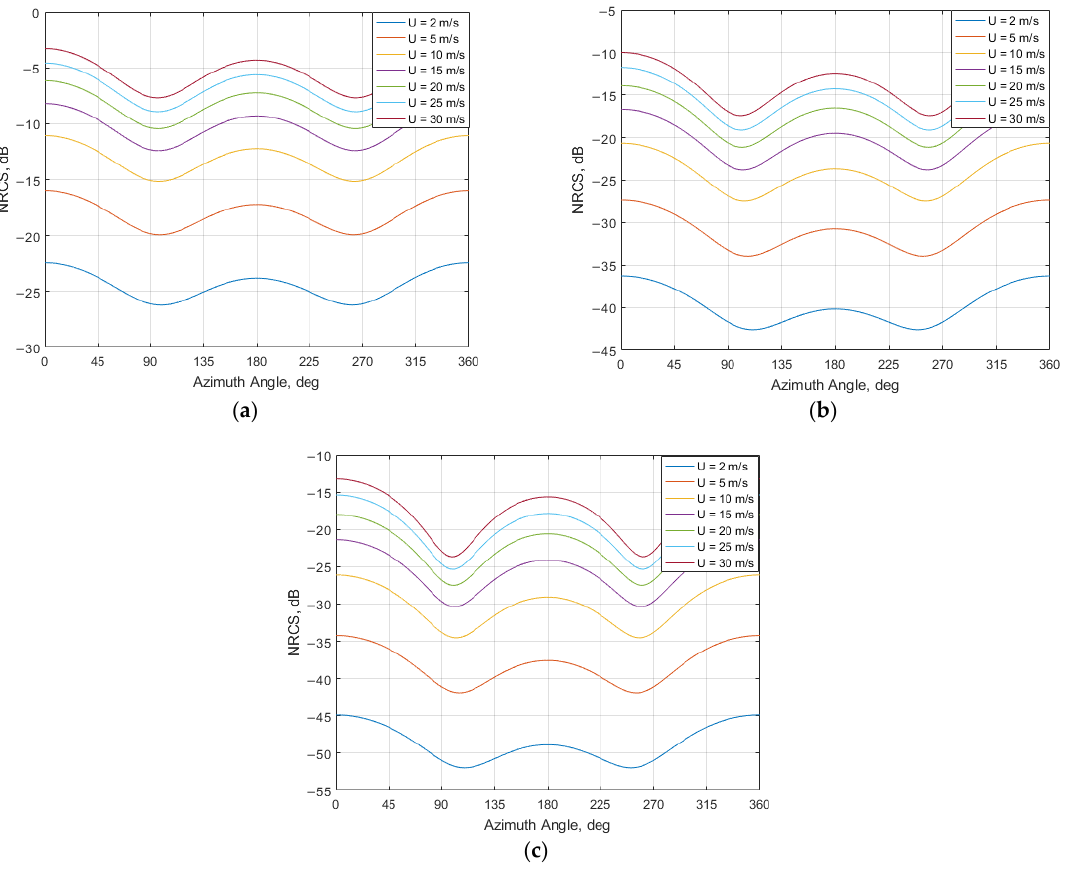
Figure A1. Ku-band GMF azimuthal curves for the horizontal transmit and receive polarization for wind speeds of 2, 5, 10, 15, 20, 25, and 30 m/s at an incidence angle of ( a ) 30°; ( b ) 45°; ( c )